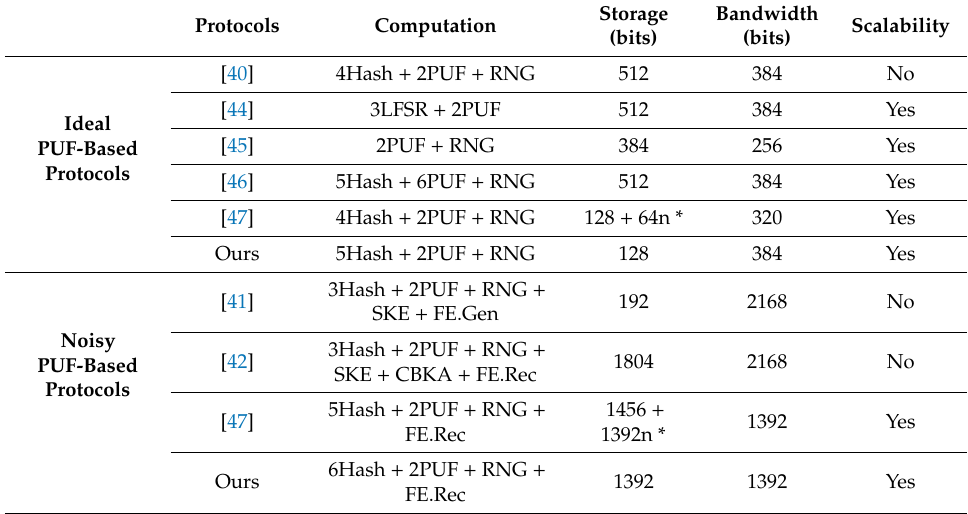
Table 4. E ffi ciency performance